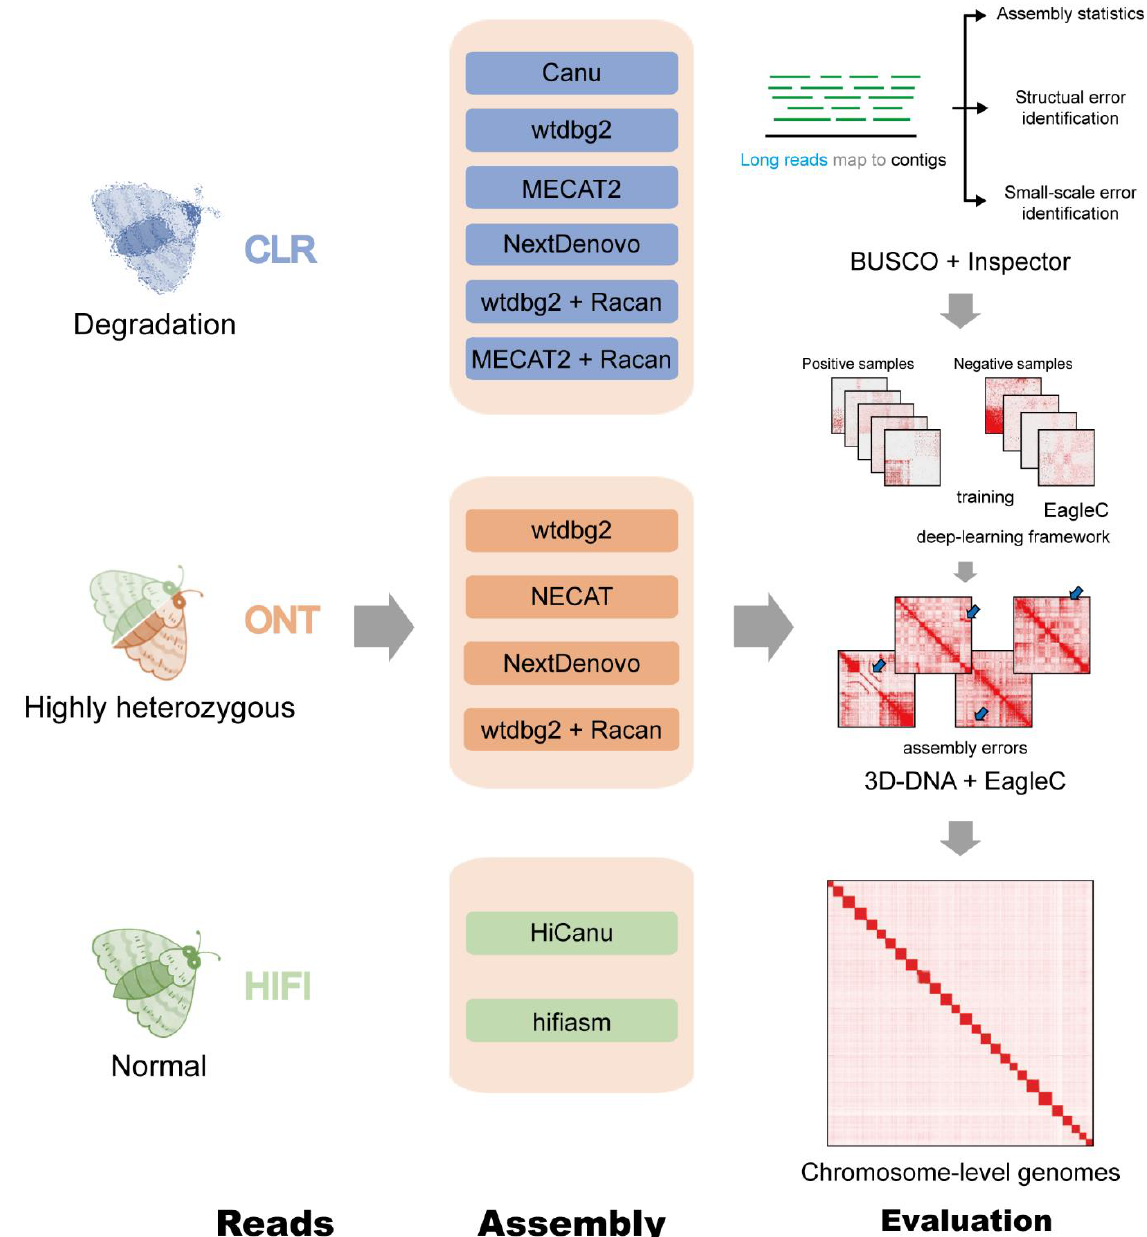
Figure 2. Summary of de novo assembly workflow and